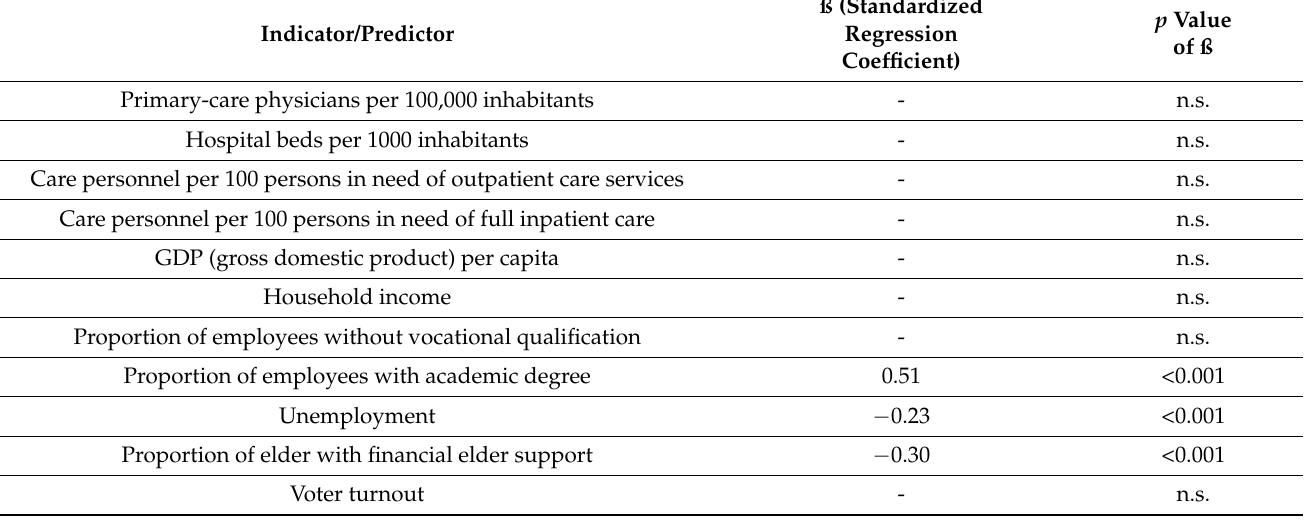
Table 5. Results of a multiple regression analysis of women’s remaining life expectancy at age 60 at district level (dependent variable) and 11 potential predictors: results for potential predictors (ß; p value of ß); N = 401 German